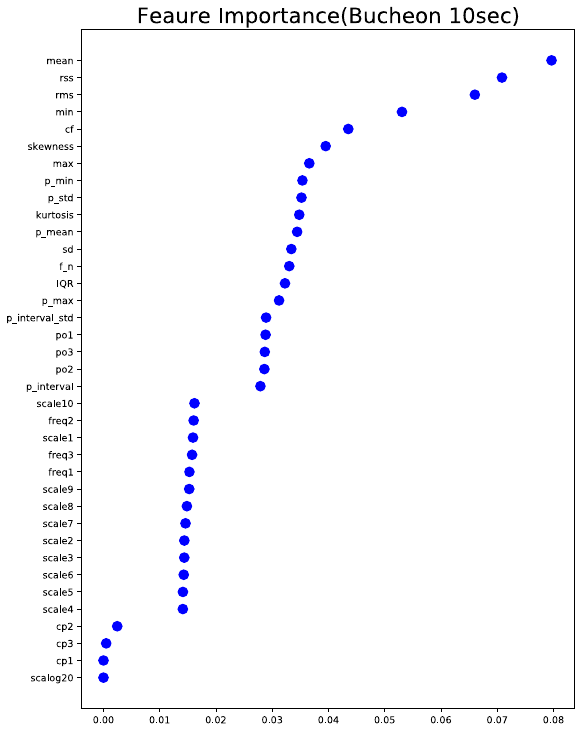
Figure 10. Feature importance plot.